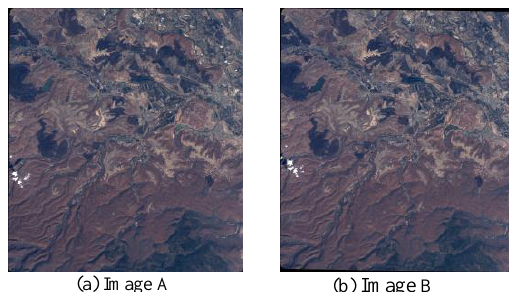
Figure 4. Stereo pair of SPOT6